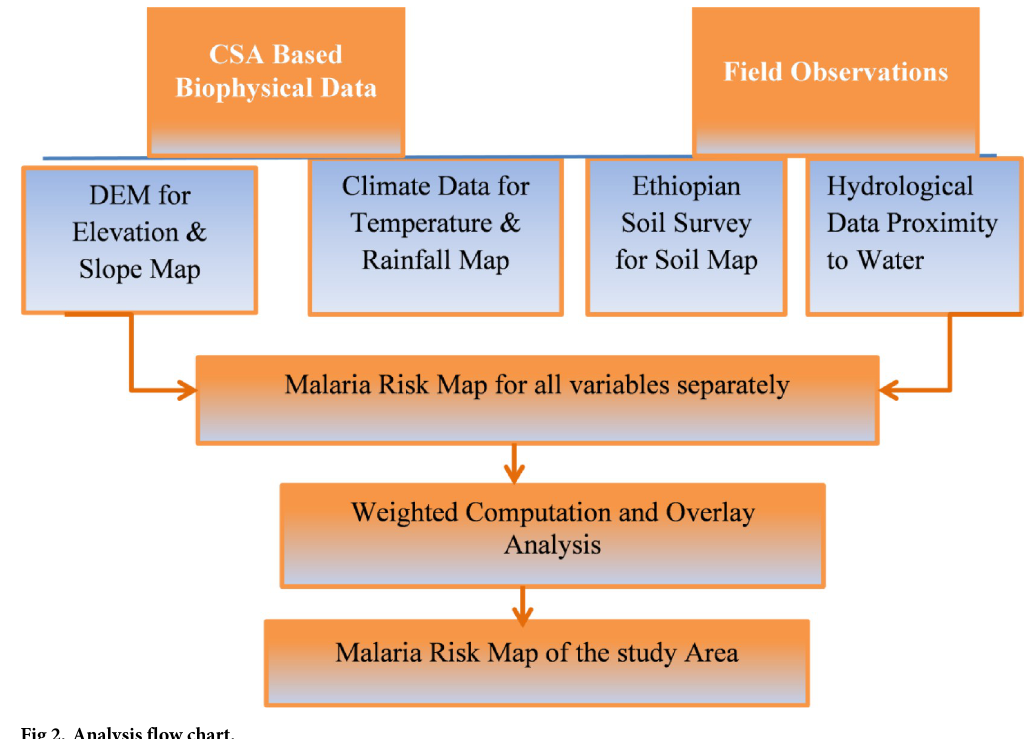
Fig 2. Analysis flow